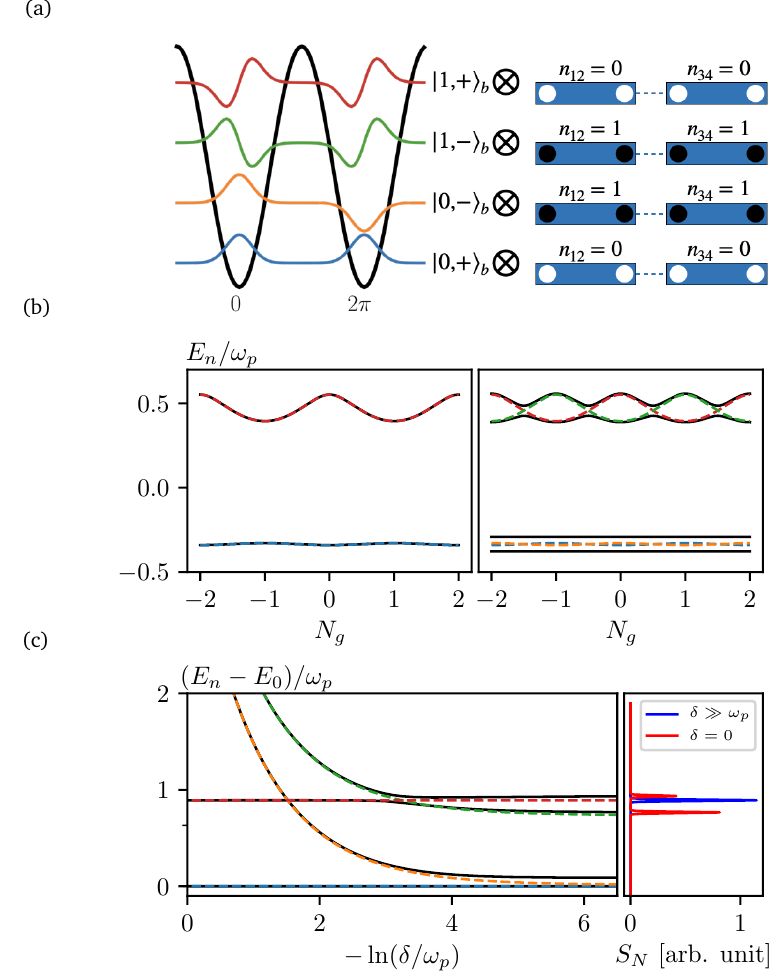
Figure 3: (a) Schematic representation of the basis states defined in Eq. (21) for m = 0,1, in terms of the 4 π -periodic bosonic wavefunctions ψ pations of the four Majorana modes present in the system. (b) The energy spectrum of the Hamiltonian (17), as a function of N δ = 0 (right panel), with junction parameters set to E lines correspond to the spectrum for E states sketched in panel (a), while the solid black lines are obtained for E (c) Excitation spectrum as a function of δ/ω δ = 5 ω (blue) and δ = 0 (red). The spectral function is convolved with a Gaussian p = 10 − 2 with σ/ω p